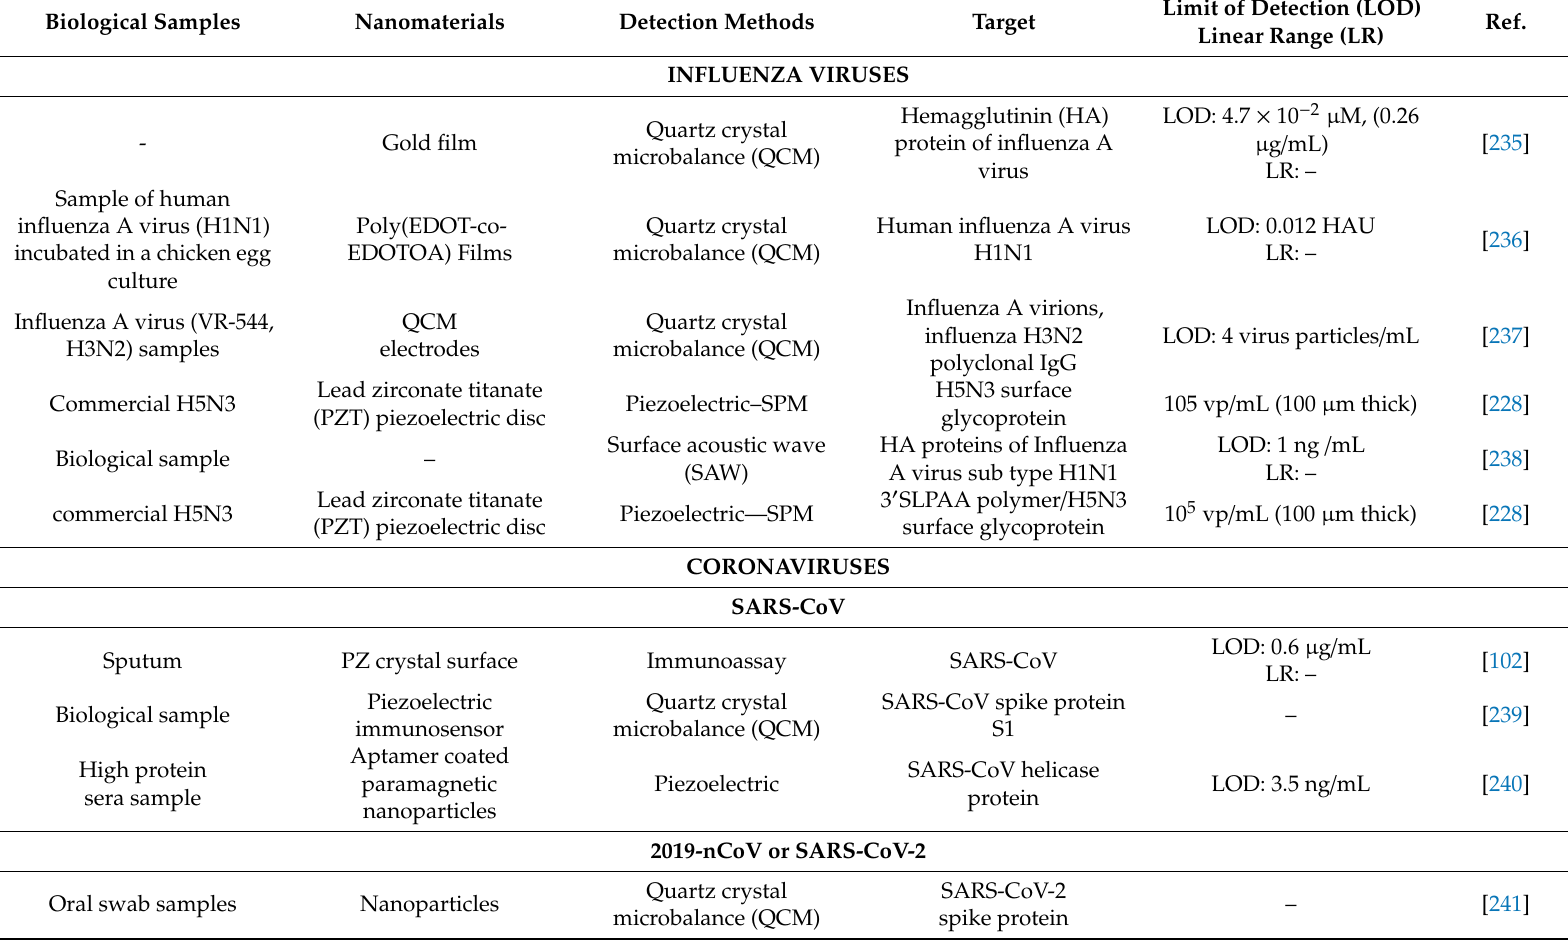
Table 6. Mass sensitive detection method and their parameters for developed SARS-CoV and influenza virus